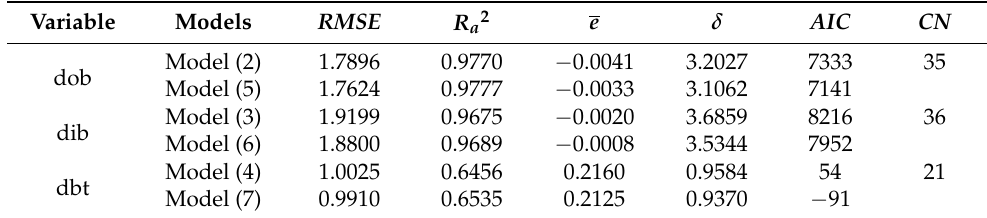
Table 2. Goodness-of-fit statistics of single estimate models with or without dummy variables.